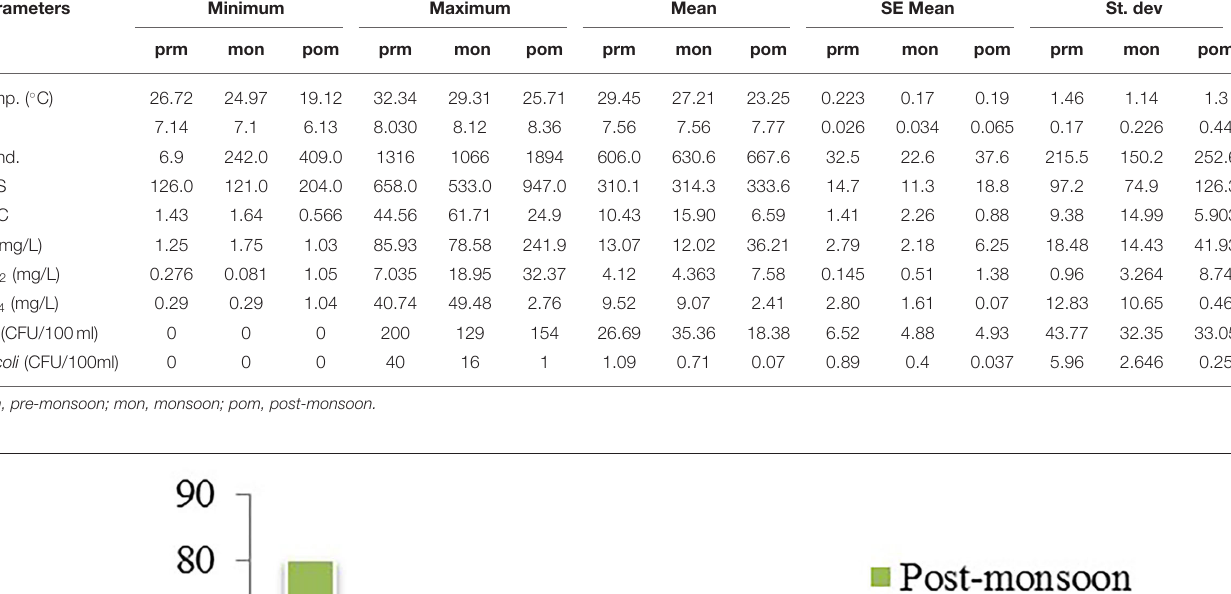
TABLE 1 | Statistical summary of the observed results of groundwater physicochemical parameters in different seasons. Parameters